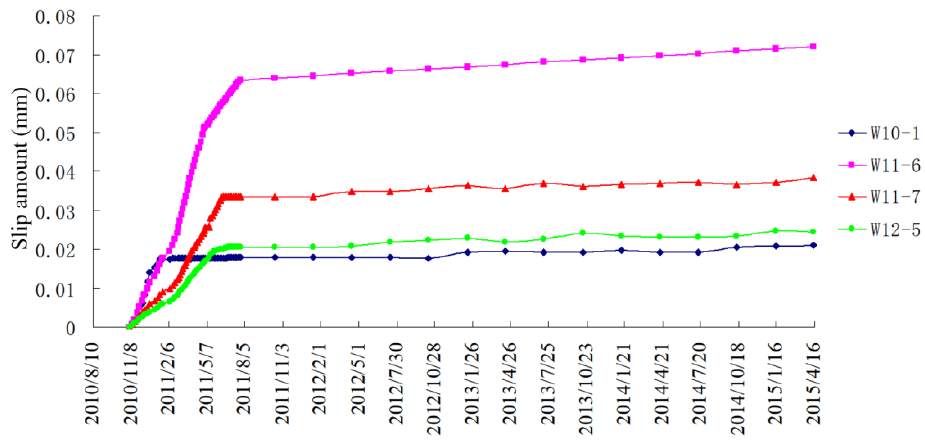
Figure 13. Multipoint displacement meter monitoring displacement–time curve of each measurement point of fault F4.